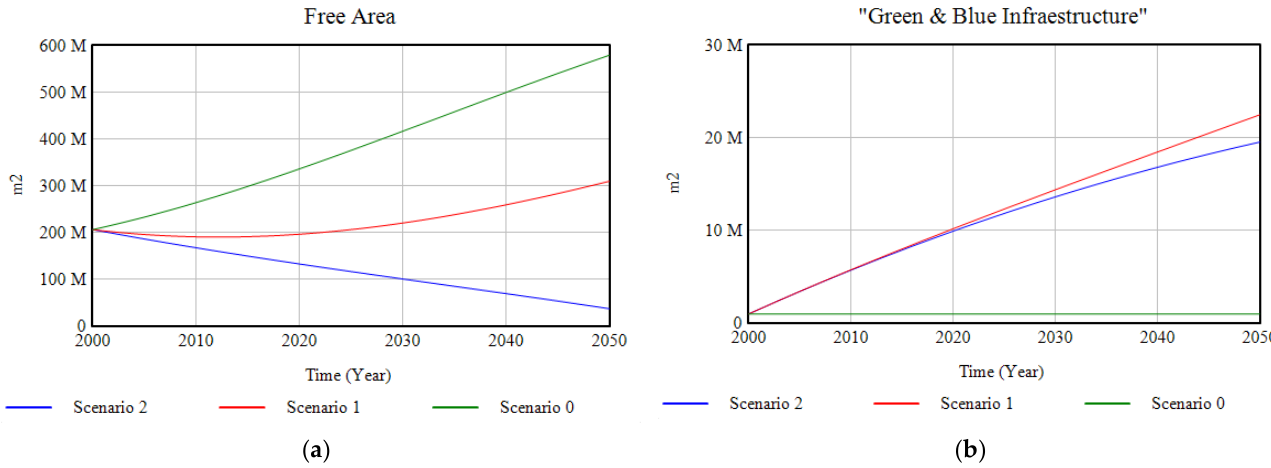
Figure 11. ( a ) Results of the modelling of the free area for the three scenarios; ( b ) results of the modelling of the green and blue infrastructure for the three scenarios, in the period 2000–2050.